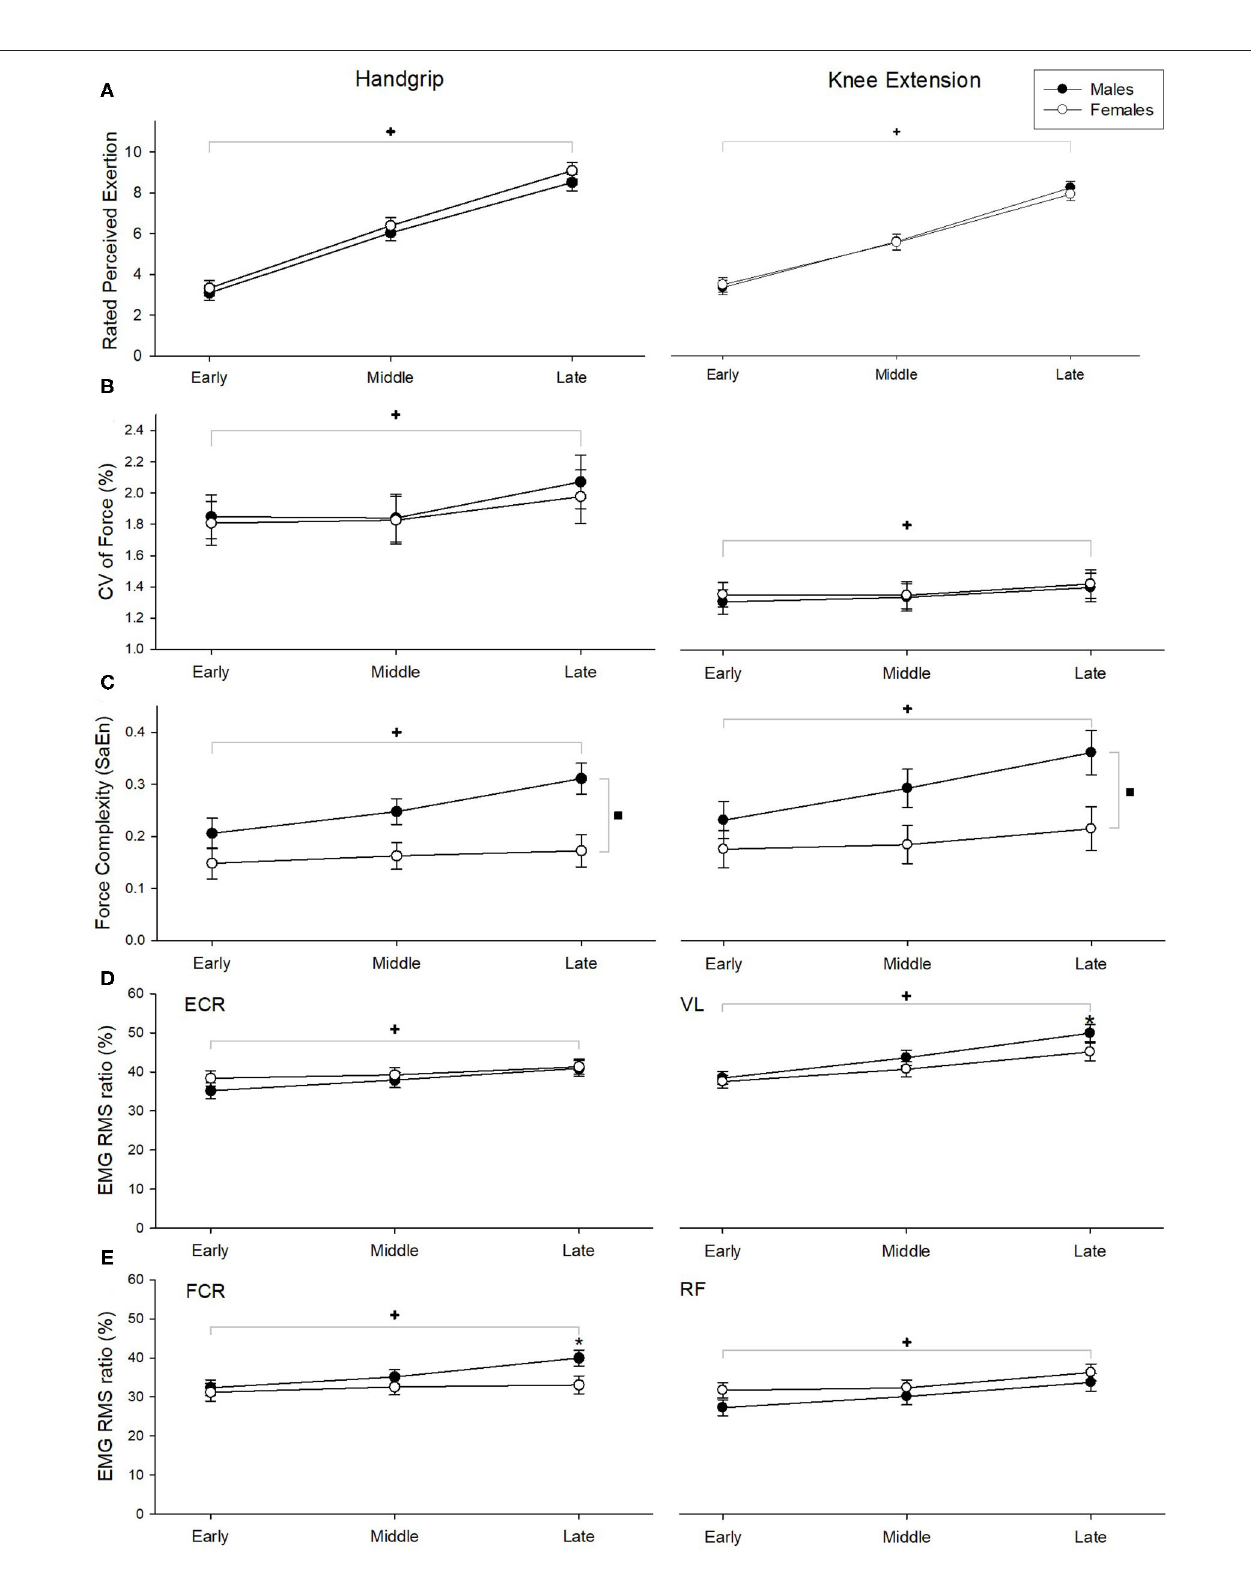
FIGURE 3 | Ratings of perceived exertion (A) , CV of force (B) , SaEn of force (C) , and EMG RMS ratio (D, E) during handgrip exercises (left column) and knee extension exercises (right column). + Indicate significant fatigue main effect, (cid:5) indicate significant sex main effect, and *indicate sex effects at the specific fatigue phase (fatigue x sex interaction). Statistical significance was determined at p < 0.05. Error bars represent standard error.